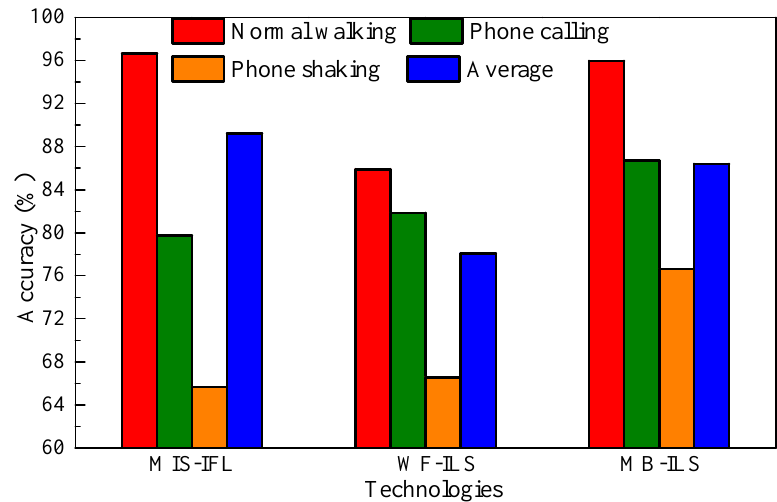
Figure 13. Accuracy of floor localization.